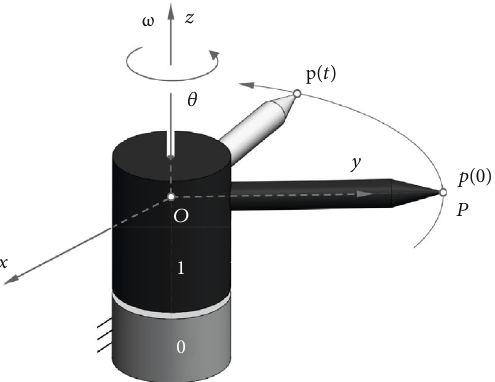
Figure 1: Rotation of rigid body 1 about the axis ω by an angle θ